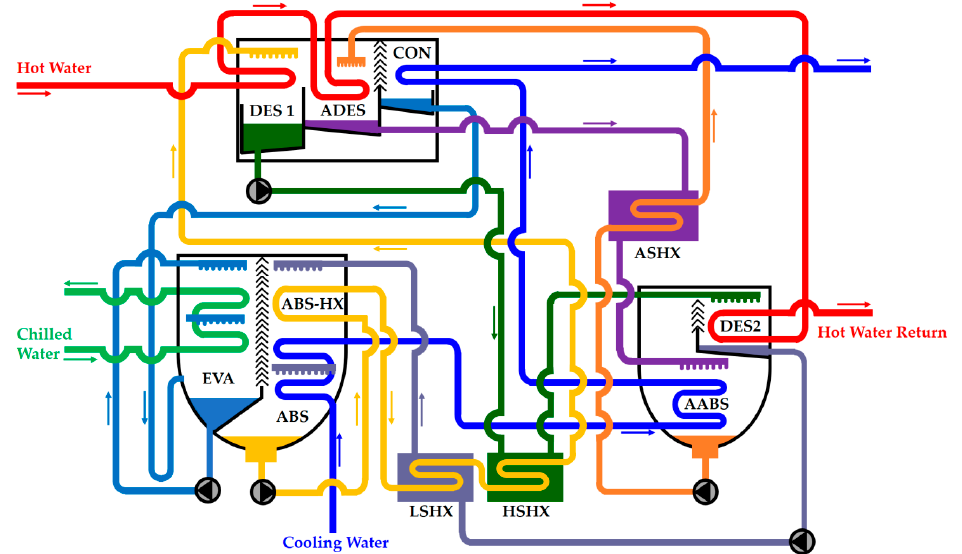
Figure 7. Singe ‐ effect double ‐ lift water/LiBr absorption cycle schematic of the absorption chiller Figure 7. Singe-e ff ect double-lift water / LiBr absorption cycle schematic of the absorption chiller developed by World Energy Co., Ltd. Adapted from Reference [36]. Note: AABS=auxiliary absorber;